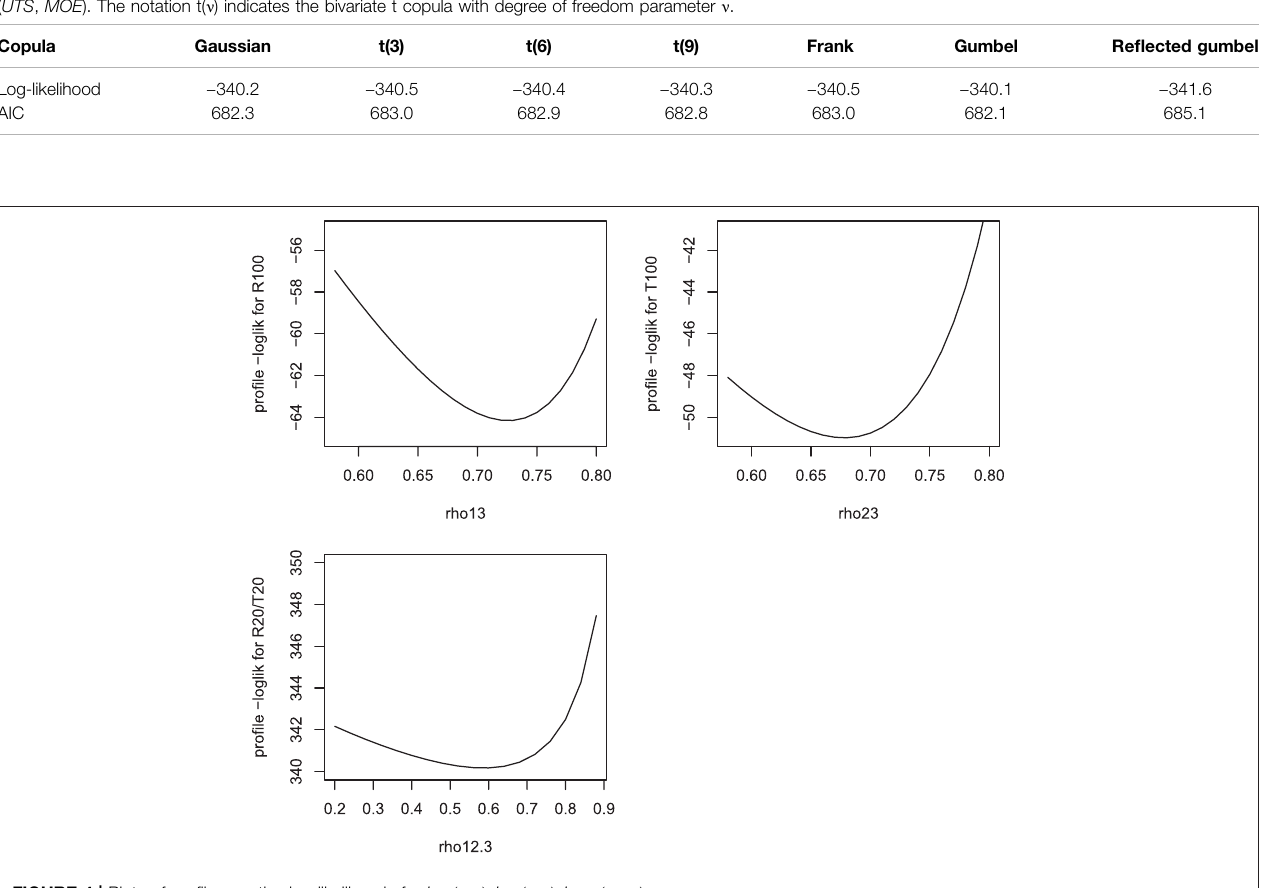
FIGURE 4 | Plots of pro fi le negative log-likelihoods for L 13 ( ρ 13 ) , L 23 ( ρ 23 ) , L 12 ; 3 ( ρ 12 ; 3 )